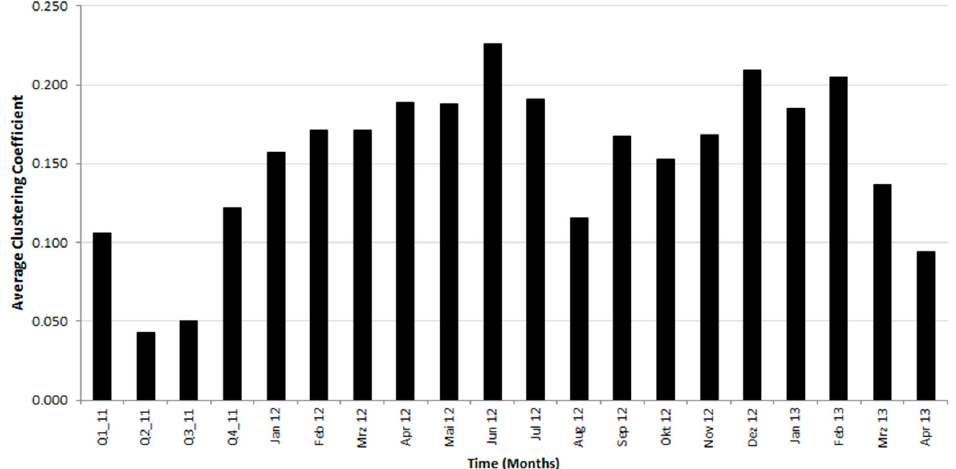
Figure 33. Average Clustering Coefficient over Time.